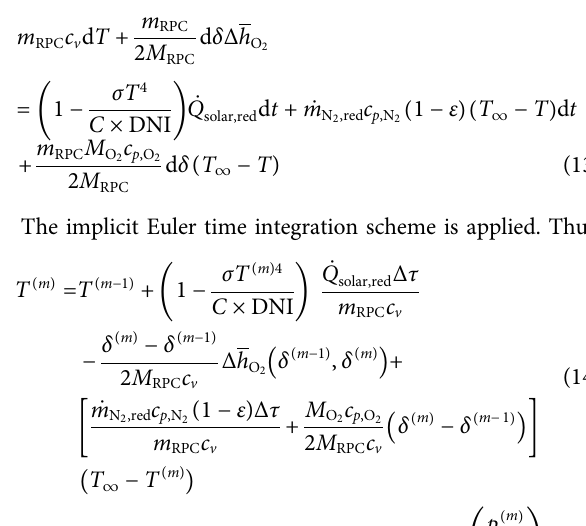
FIGURE 4 | Schematic of system model of State 3 to State 4 for the n th reaction